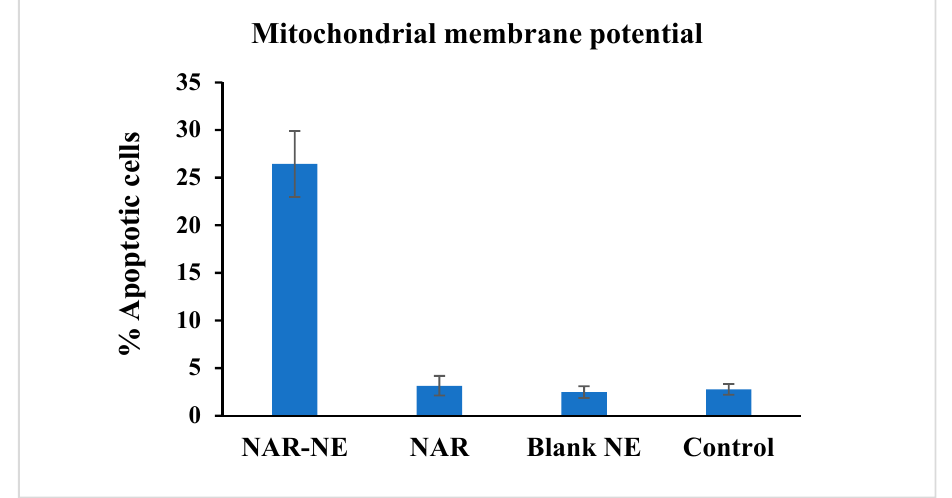
Figure 10. Effect of the free NAR, blank NE, and NAR-NE (IC 50 concentrations) in producing apoptosis in A549 cancer cells, as determined by measurement of mitochondrial membrane potential ( p < 0.05 for free NAR vs. NAR-NE).